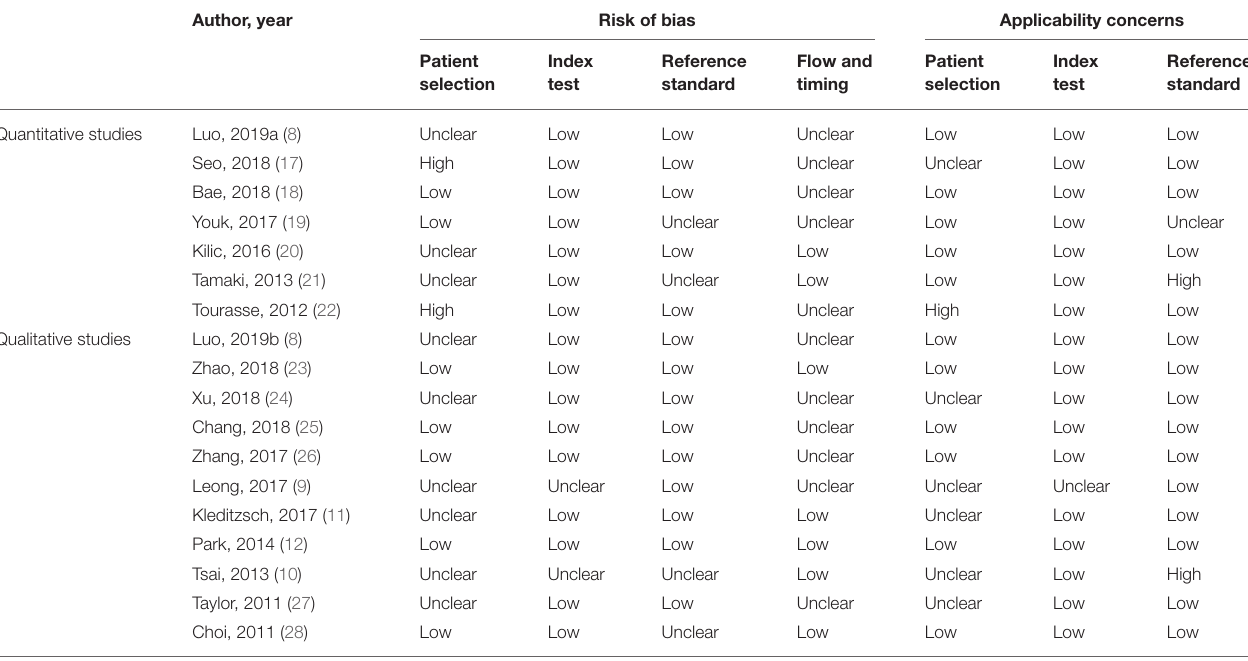
TABLE 2 | Quality assessment of the included